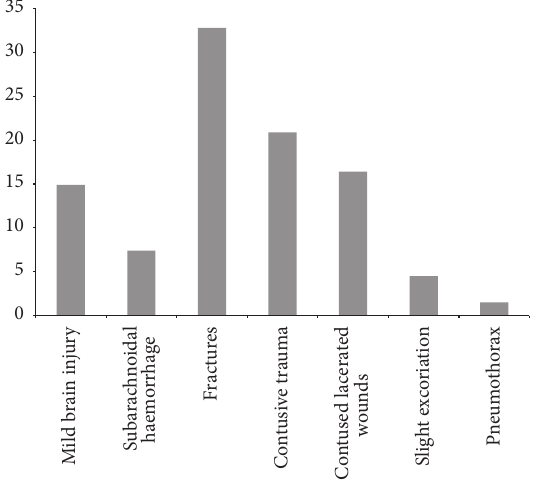
Figure 2: Type of injuries in E-cyclists in percentage